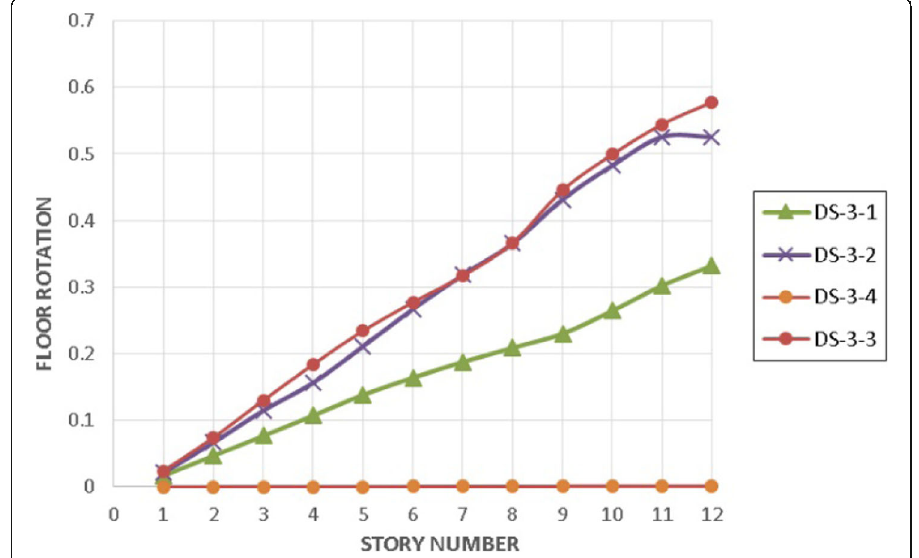
Fig. 34 Comparison of floor rotations — floor number for (DS-3-1, DS-3-2, and DS-3-3, and